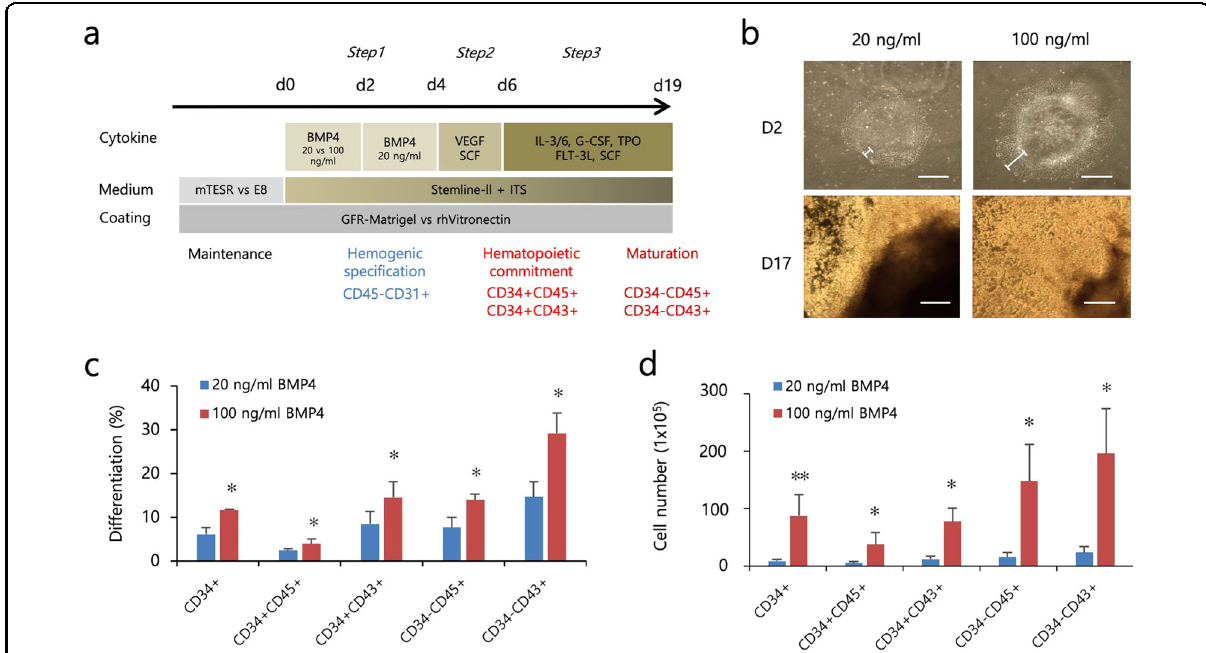
Fig. 1 Comparison of the effects of low- and high-dose BMP4 on the hematopoietic differentiation of hPSCs. a A schematic overview of the stepwise hematopoietic induction protocol for hESCs (CHA15) and hiPSCs (hEF12-2 and iPS-NT4-S1). b Representative bright- fi eld images of colonies at the early (day 2) and late (day 17) stages of hematopoietic differentiation with BMP4 (20 vs 100 ng/mL). Scale bar, 200 μ m. c , d Effects of low- and high-dose BMP4 on the induction ef fi ciency ( c ) and the yield ( d ) of hematopoietic lineage cells from hPSCs were analyzed by fl ow cytometry. The bars indicate the mean ± SD; * p < 0.05, ** p <